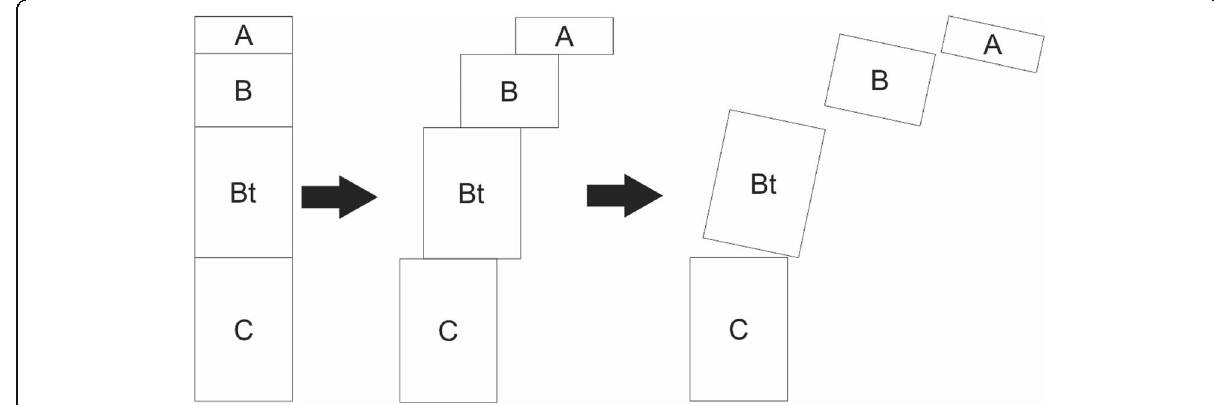
Fig. 7 Illustration of soil layer arrangement at the head part as a result of landslide movement